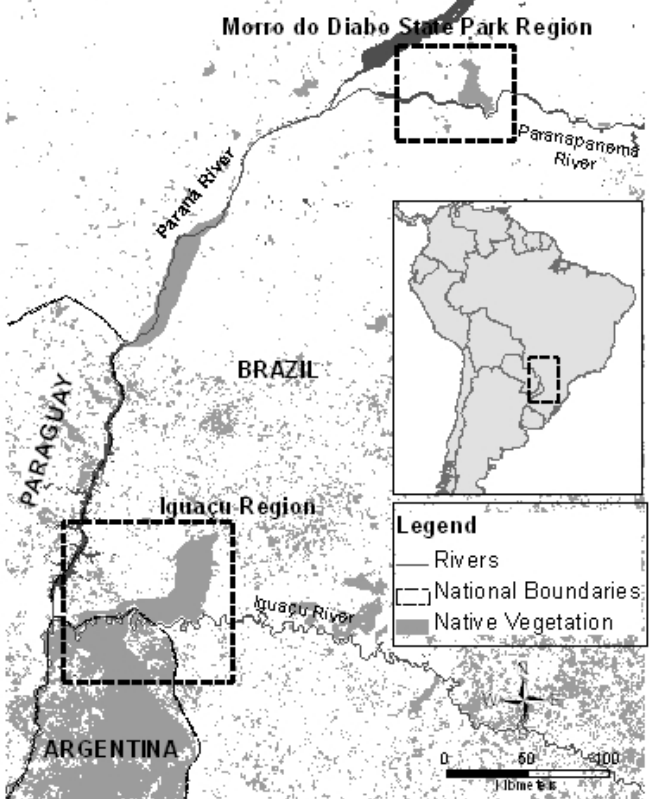
Figure 1. Upper Parana ecoregion and the sampled areas. Each square represents the origin of the samples collected. The gray areas represent the remaining native